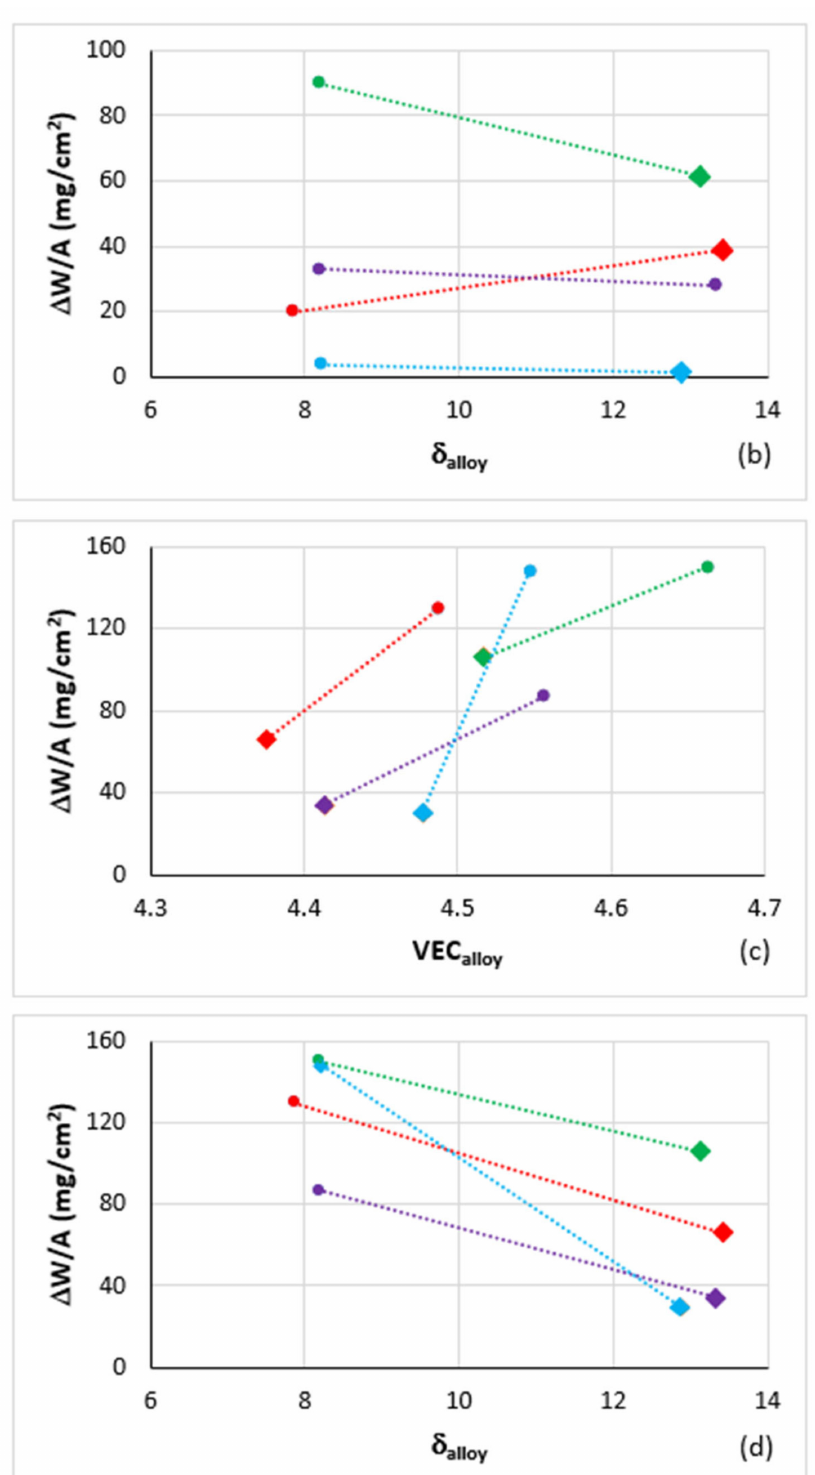
Figure 13. Mass change ( ∆ W/A) of the alloys TT2, TT3, TT4, TT8 and their basis/reference alloys KZ4, KZ5, KZ7 and JG3 versus the parameters ( a , c ) VEC and ( b , d ) δ for isothermal oxidation ( a , b ) at 800 ◦ C and ( c , d ) at 1200 ◦ C. Colours as follows: green for TT2 and KZ4, red for TT3 and KZ7, purple for TT4 and KZ5, and blue for TT8 and JG3. Diamonds for B containing